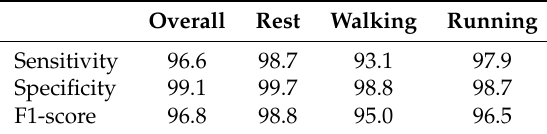
Table 5. Classification results, using the supervised model (Sup-AXGZ8) on continuous test data on a per sample basis. All calculated per person and then per class and displayed as a percentage.